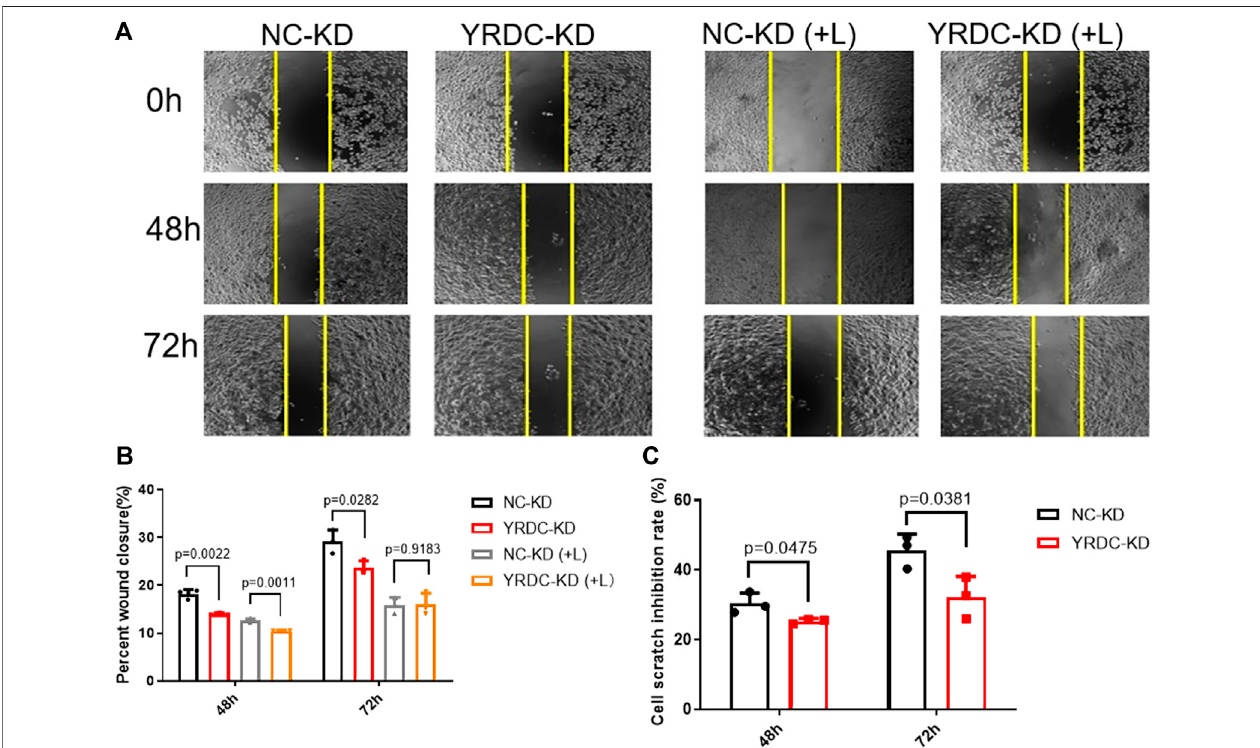
FIGURE 2 | The knockdown of YRDC attenuates cellular sensitivity to lenvatinib in a wound-healing assay. (A) The knockdown of YRDC attenuates the antimigration effect of lenvatinib (0.8 μ M) through the scratch experiment. (B) The migrating areas were measured at 48 and 72 h after the introduction of wounds in Huh7 cells with lenvatinib. (C) The cell scratch inhibition rate refers to the inhibition rate after lenvatinib addition. Dots in the graphs mean biological repetitions, n (cid:2)